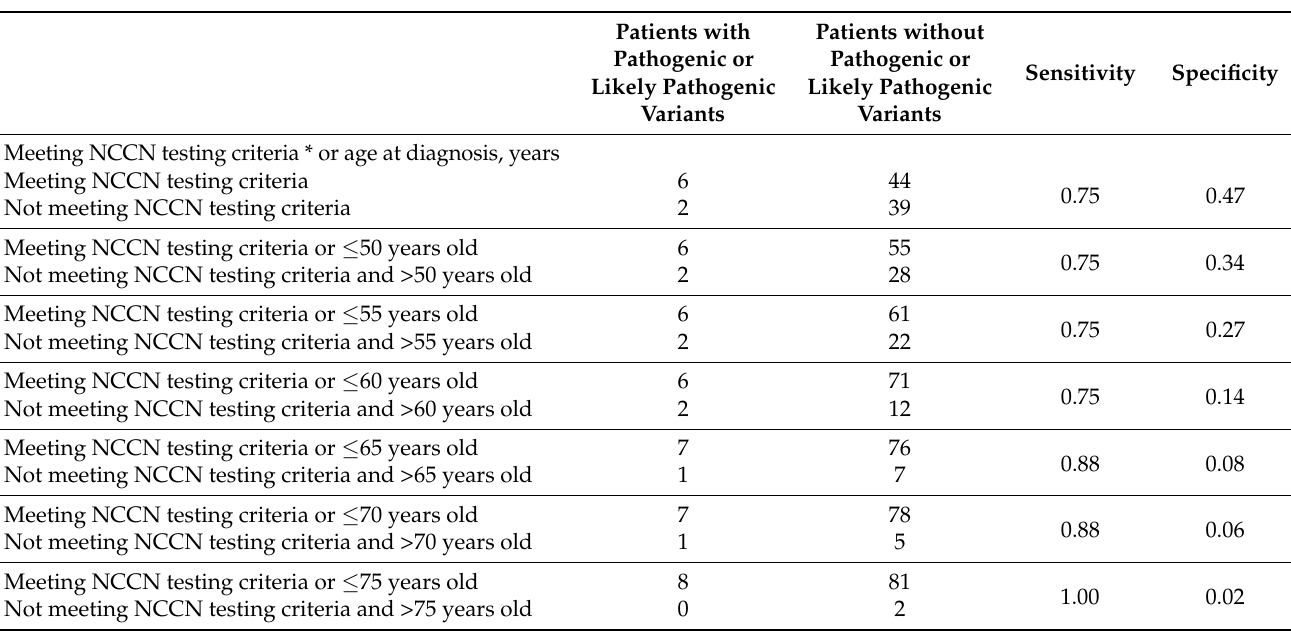
Table 2. Sensitivity and